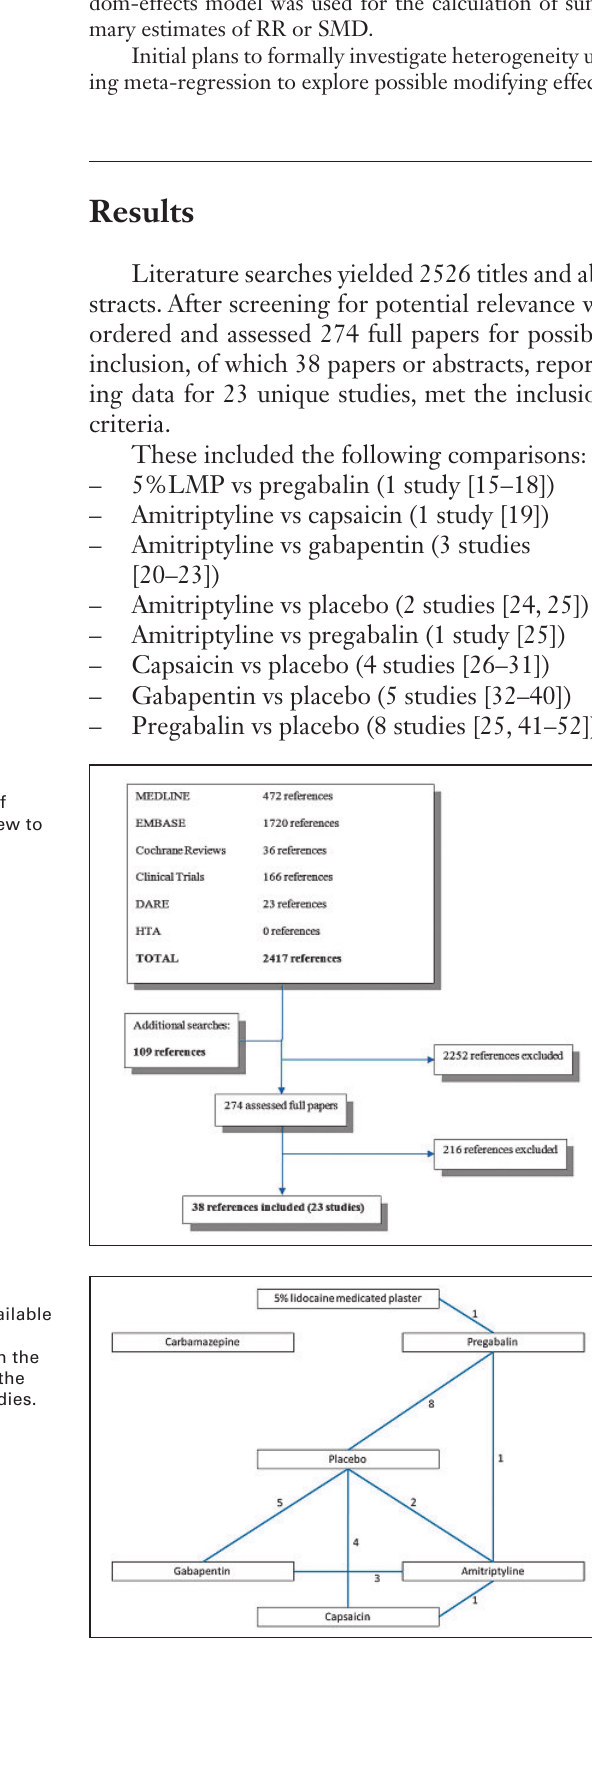
Overview of available comparisons. The numbers on the links represent the numbers of